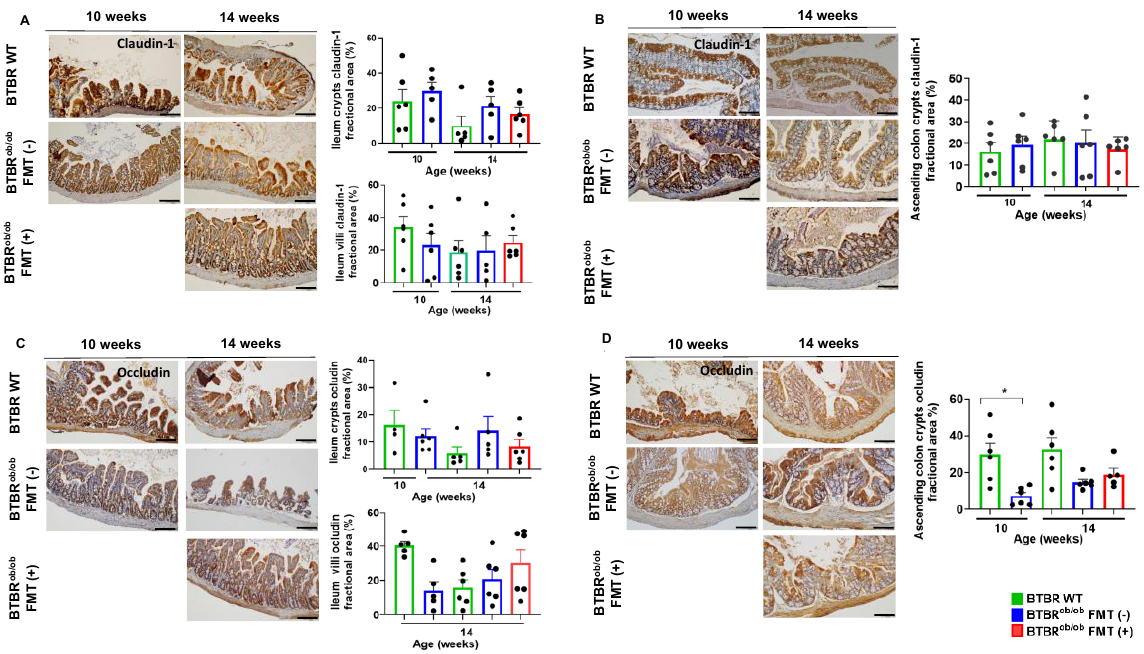
Figure 7. Immunohistochemical evaluation of claudin-1 and occludin proteins in ileum and ascending colon in BTBR ob/ob FMT (+) and BTBR ob/ob FMT ( − ) mice compared to BTBR WT mice. ( A ) Claudin-